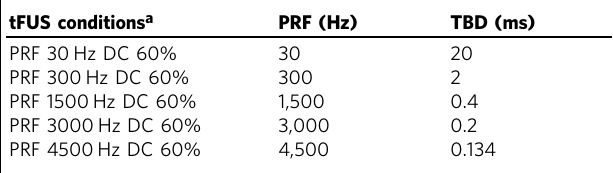
Table 2 Administered tFUS conditions with a constant DC of